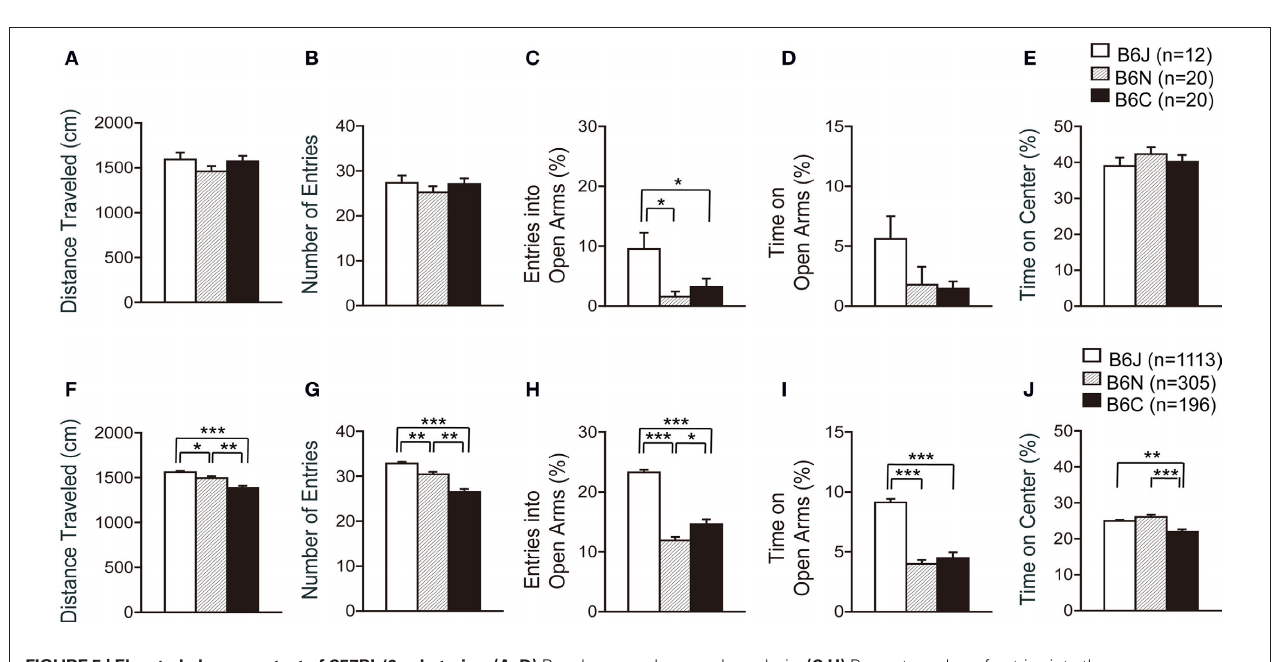
Figure 5 | elevated plus maze test of C57BL/6 substrains. (A–D) Regular scale analysis. (e–H) Large-scale analysis. (A,F) Total distance traveled. C57BL/6J mice traveled the longest distance in the large-scale analysis. (B,g) Number of entries into the center crossing between the open and closed arms. C57BL/6J showed the largest number of total arm entries in the